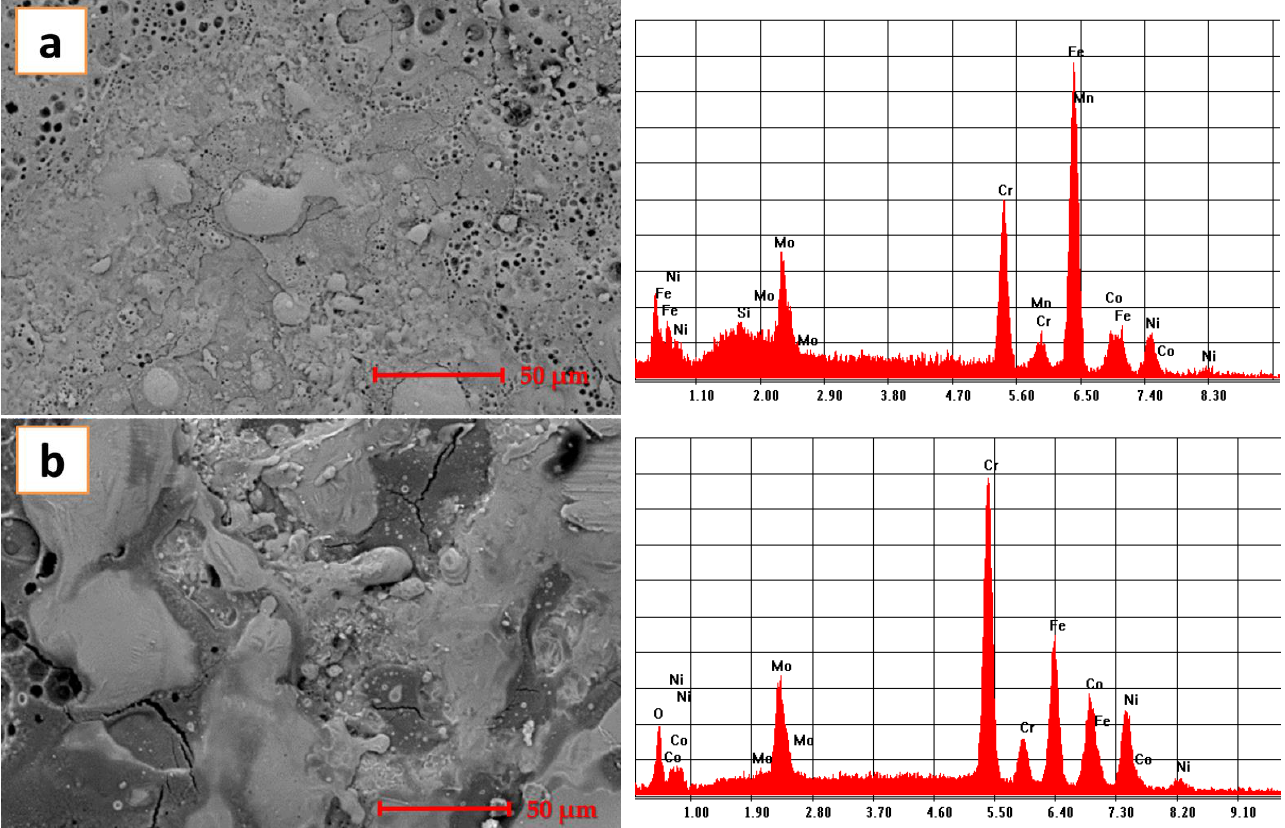
Figure 8. CoCrFeNiMo 0.85 coating before ( a ) and after ( b ) exposure to corrosion.